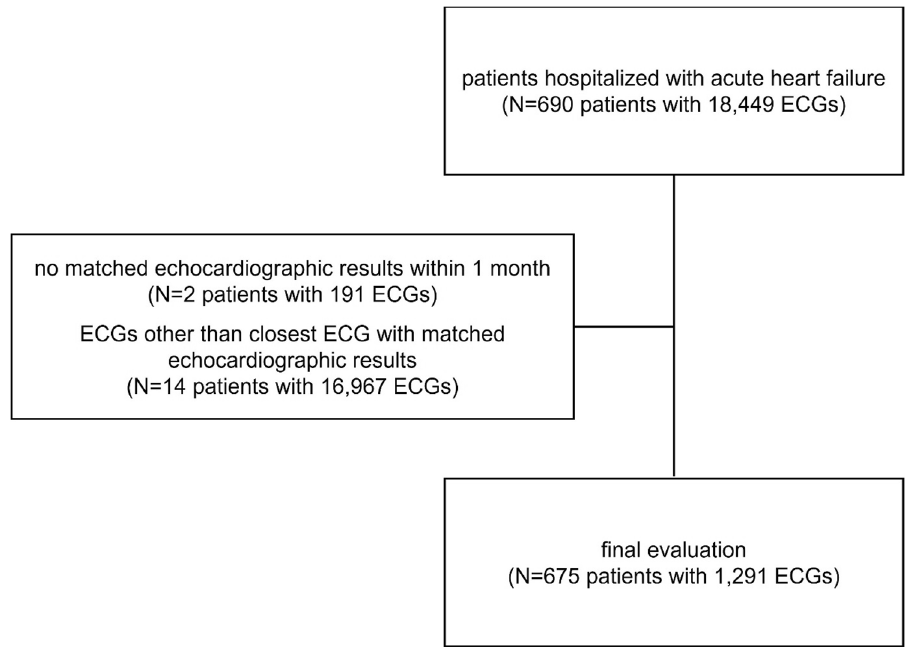
Figure 1. Study flow chart—Among the patients hospitalized with acute heart failure, subjects with no matching echocardiographic results within 1 months and electrocardiograms other than closest match to the echocardiographic results were excluded. ECG